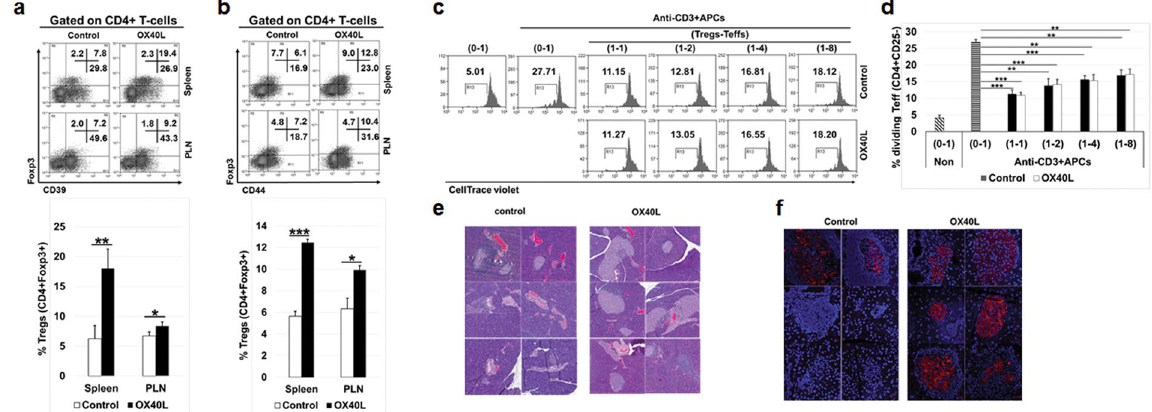
Figure 2. OX40L treatment leads to expansion of functional Tregs in vivo . NOD mice were injected i.p. with either PBS or OX40L three times (200 µ g/mouse/week). One week after the last treatment, mice were euthanized and cells were collected for analysis. ( a ) Representative dot plots (left) and bar graphs (right) show Foxp3 and CD39 expression in spleen and PLN. ( b ) Representative dot plots (left) and bar graphs (right) show Foxp3 and CD44 expression in spleen and PLN. ( c , d ) Splenic Teffs and Tregs were isolated from the untreated and treated mice and used in an ex vivo suppression assay. ( c ) Representative histograms show results from the ex vivo suppression assay. ( d ) Bar graphs summarizing results shown in C. Values show average ± SD, * P < 0.05, ** p < 0.005, and *** p < 0.0005. ( e ) H&E stained pancreatic tissue sections from untreated and OX40L-treated NOD mice showing different degrees of lymphocytic infiltration and islet damage at 23 weeks of age. ( f ) Immunofluorescence microscopy of pancreatic tissue sections stained with anti-insulin antibody.